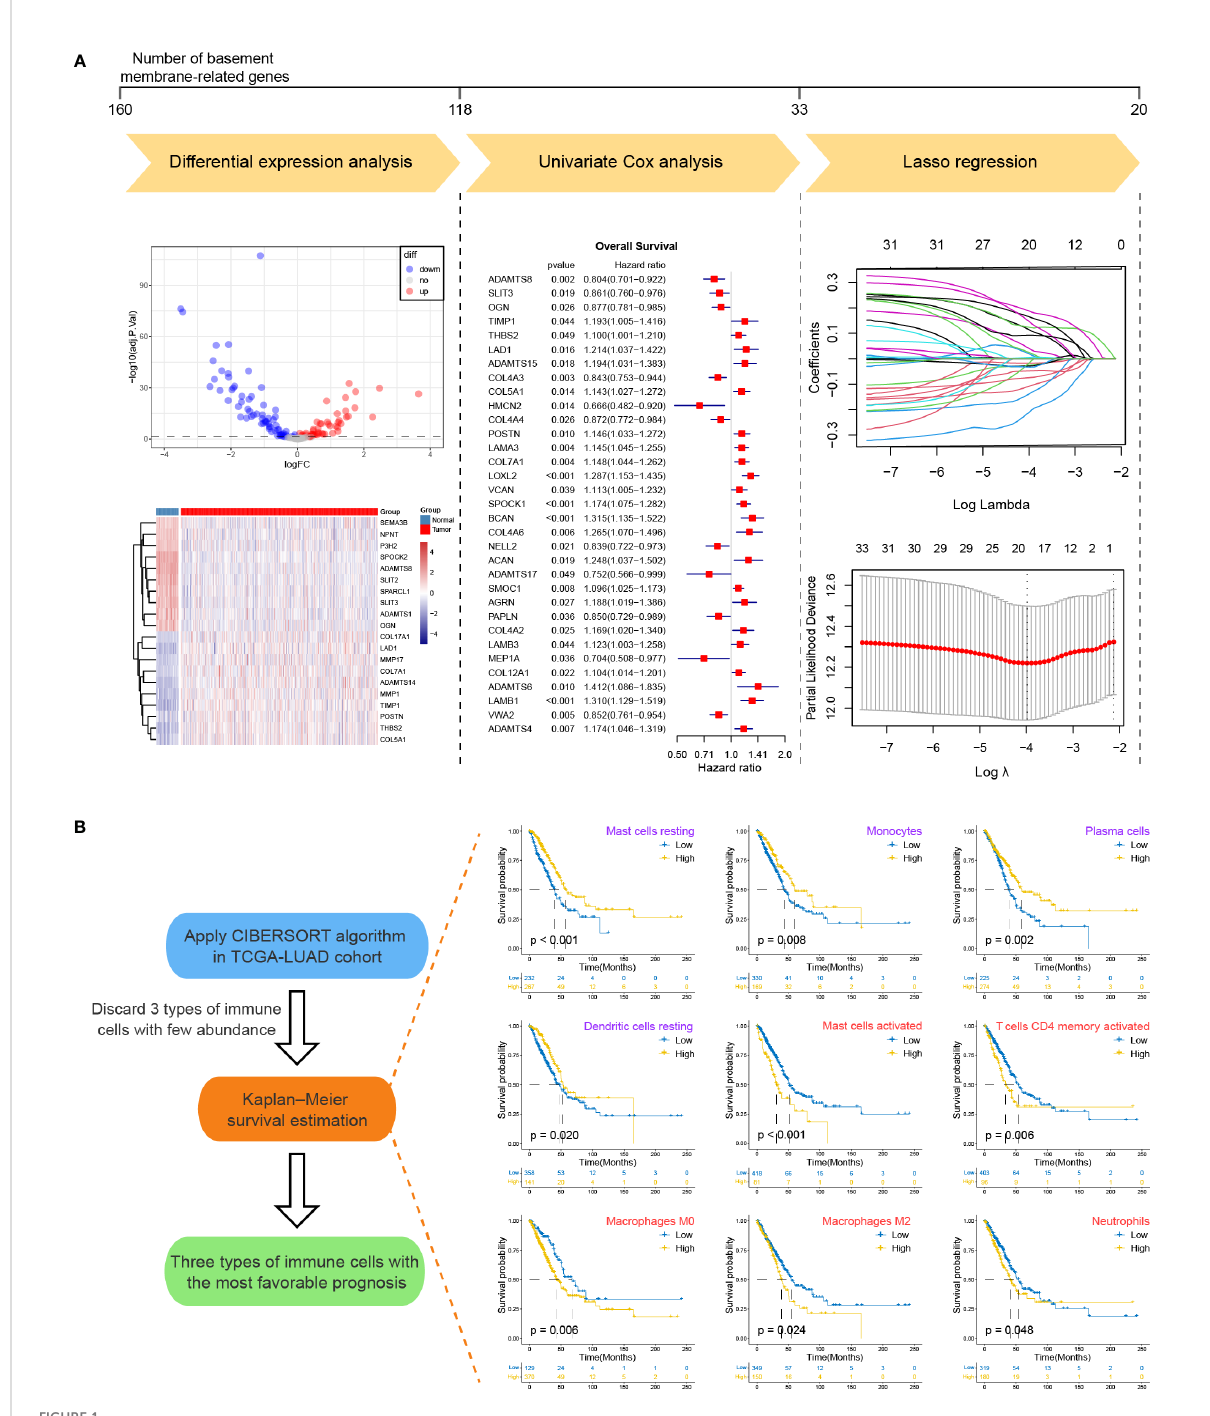
FIGURE 1 The work fl ow for screening basement membrane-related genes and immune cell types for establishing the BM score and TME score. (A) Differential expression analysis, univariate Cox regression analysis and lasso regression analysis were performed for 160 BM-related genes in TCGA-LUAD cohort in succession. The upper line marked the number of BM-related genes before and after each step analysis. Brie fl y, 20 BM-related genes were selected for the development of BM score. (B) The CIBERSORT algorithm was applied to generate the abundance of 22 types of immune cells for TCGA-LUAD samples. After abandoning 3 types of immune cells with few abundances, Kaplan-Meier survival curve estimation was executed for the remaining immune cell types. Kaplan-Meier overall survival curves were shown on the right side only for immune cell types with p-values less than 0.05 (purple indicated favorable prognostic factor while red represented unfavorable prognostic factor). Ultimately, mast cells resting, monocytes and plasma cells were used for the establishment of TME